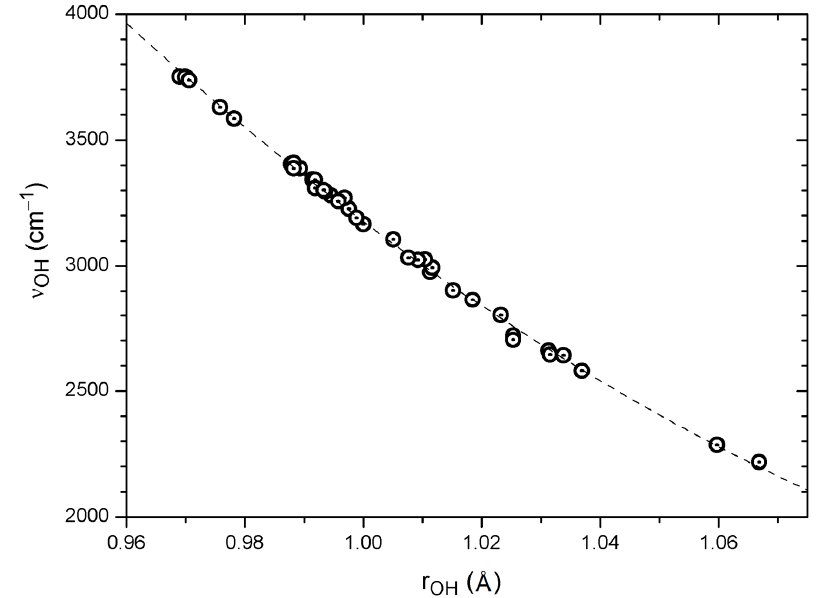
Figure 2. Correlation of calculated harmonic ν OH wavenumbers with the corresponding OH distances for 39 OH···O=C systems, including also a few non-hydrogen bonded OH groups (see text). The regression curve is Y = 68,030.6 − 111908.717 · X + 47,055.135 · X 2 (39 pts: R = –0.999, SD = 17 cm − 1 ). Finally, an excellent linear correlation is observed between calculated ν OH wavenumbers and Wiberg bond indices [95,96] for H···O distances, as shown in Figure 3 (33 data points: R = − 0.996, SD = 30 cm − 1 ). The Wiberg bond indices were computed in a basis of natural atomic orbitals (NAO) [97] using the Gaussian software package [80]. The Wiberg bond index is designed as a measure of covalent bonding. The excellent correlation in Figure 3 indicates a tendency towards increased covalent character when moving from weaker to stronger hydrogen bonds. The question of the covalency of hydrogen bonding has recently been discussed by several authors [7,8,10].